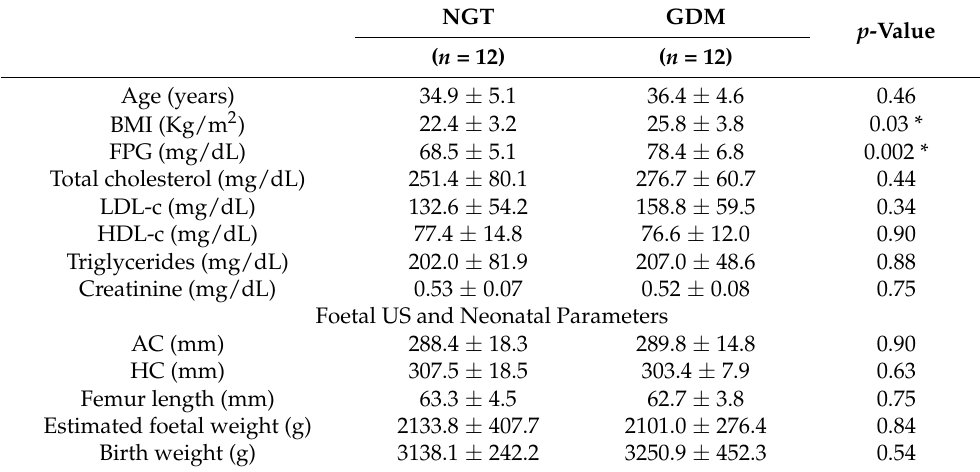
Table 2. Clinical and biochemical parameters of the validation